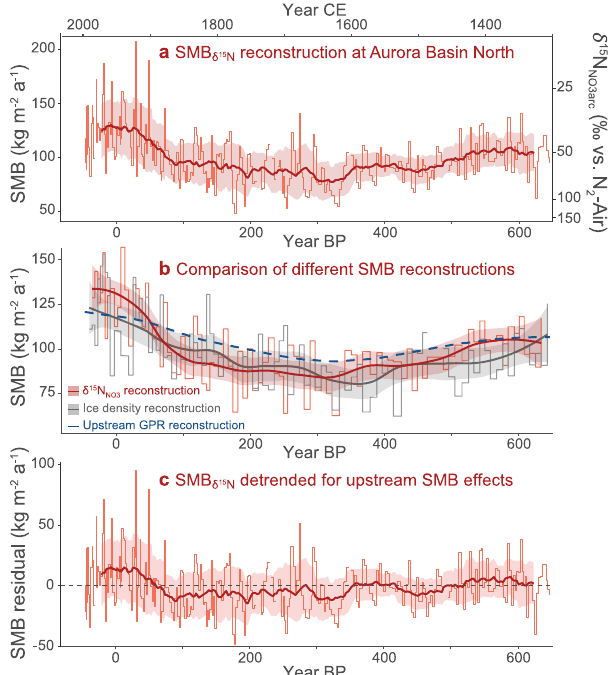
Fig. 4 Reconstructions of surface mass balance (SMB) for an Antarctic ice core from ABN. a SMB for Aurora Basin North based on δ 15 N NO3arc data from the ABN1314-103 ice core. Reconstructed SMB δ 15N values are shown by the red stepped lines with the 50-yr running mean±1 σ overlaid as a darker thick line and shaded zone. b Comparison of SMB values reconstructed from δ 15 N NO3arc (red) with those from ice density (gray) and upstream GPR isochron depth 48 . The SMB δ 15N and SMB GPR values were aggregated to match the 1-m resolution of the SMB density data. For SMB δ 15N and SMB density , smoothed LOESS curves are overlaid to more clearly show long-term patterns. c SMB δ 15N values after the upstream topographic impact on SMB has been removed, with 50-yr running mean±1 σ values overlaid. The resulting residuals may better illustrate SMB variability due to climate